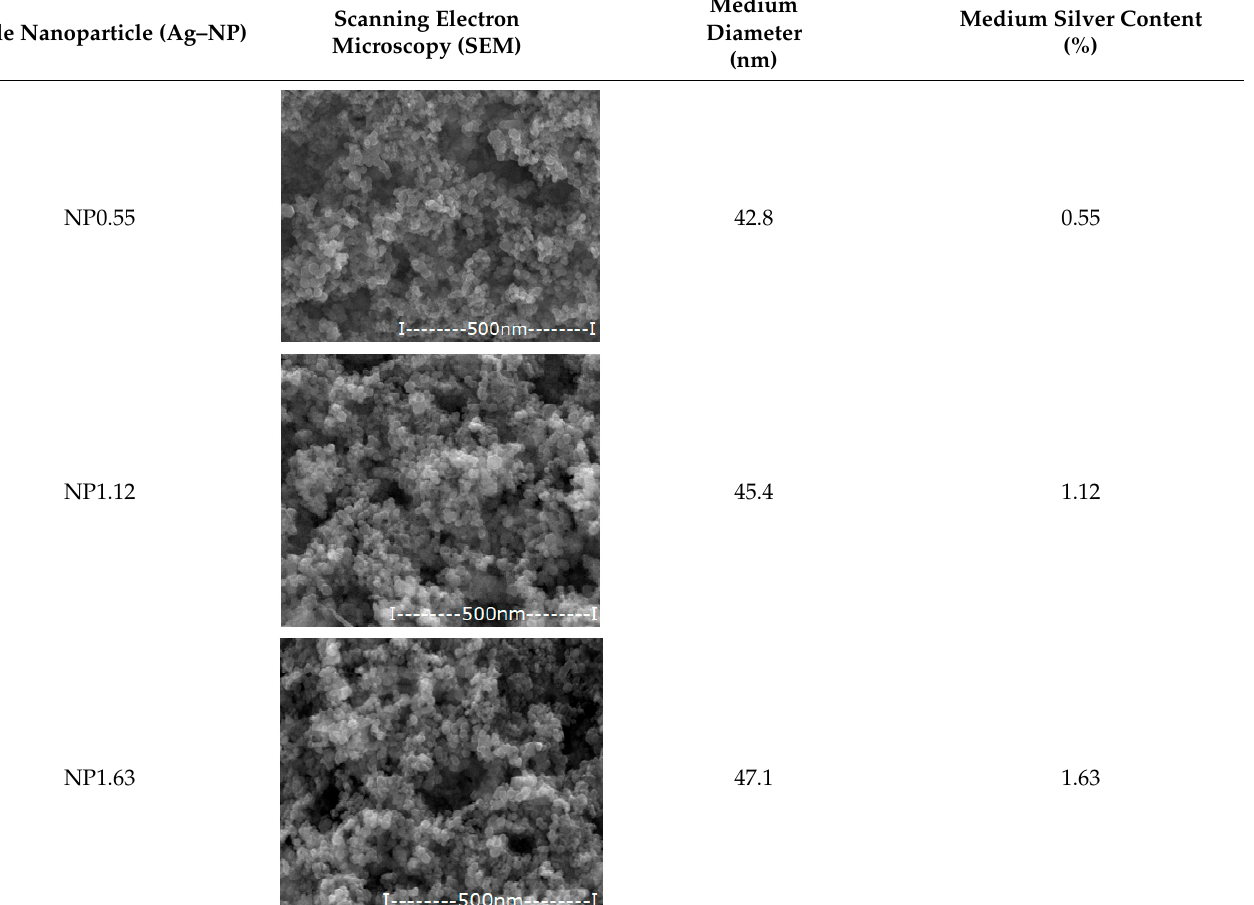
Table 4. The characteristics of the silver–iron oxide nanoparticles.